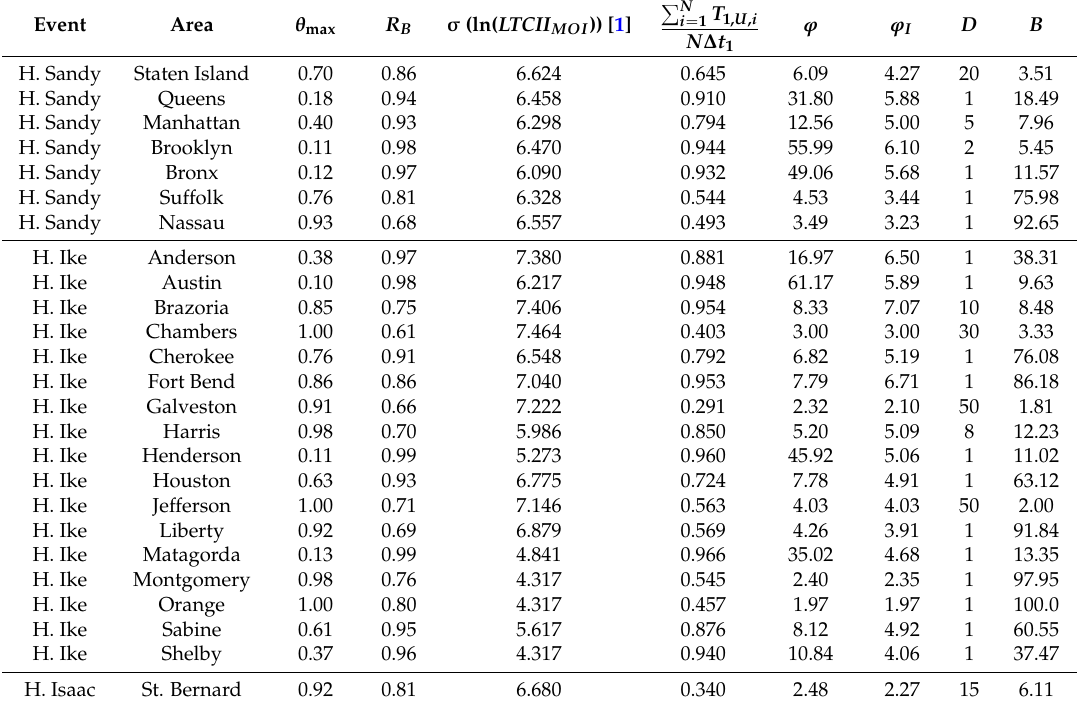
Table 2. Resistance and brittleness in various areas affected by hurricanes Sandy and Ike and St. Bernard Parish affected by Hurricane Isaac in